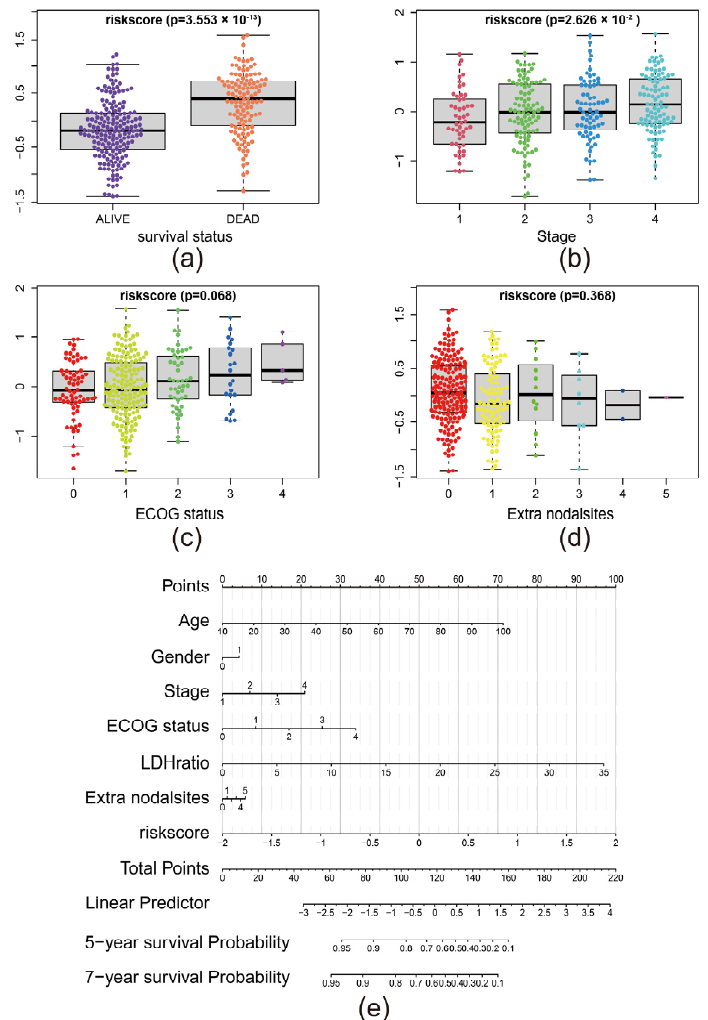
Figure 5. The risk score predicted the advance of DLBCL: ( a – d ) Risk score distribution in different survival, stage, ECOG status, extra nodal sites group; ( e ) Nomogram of the risk model based on age, gender, stage, ECOG status, LDH ratio, extra nodal sites, and risk score. In Gender, item 0 stands for male, and item 1 stands for female.